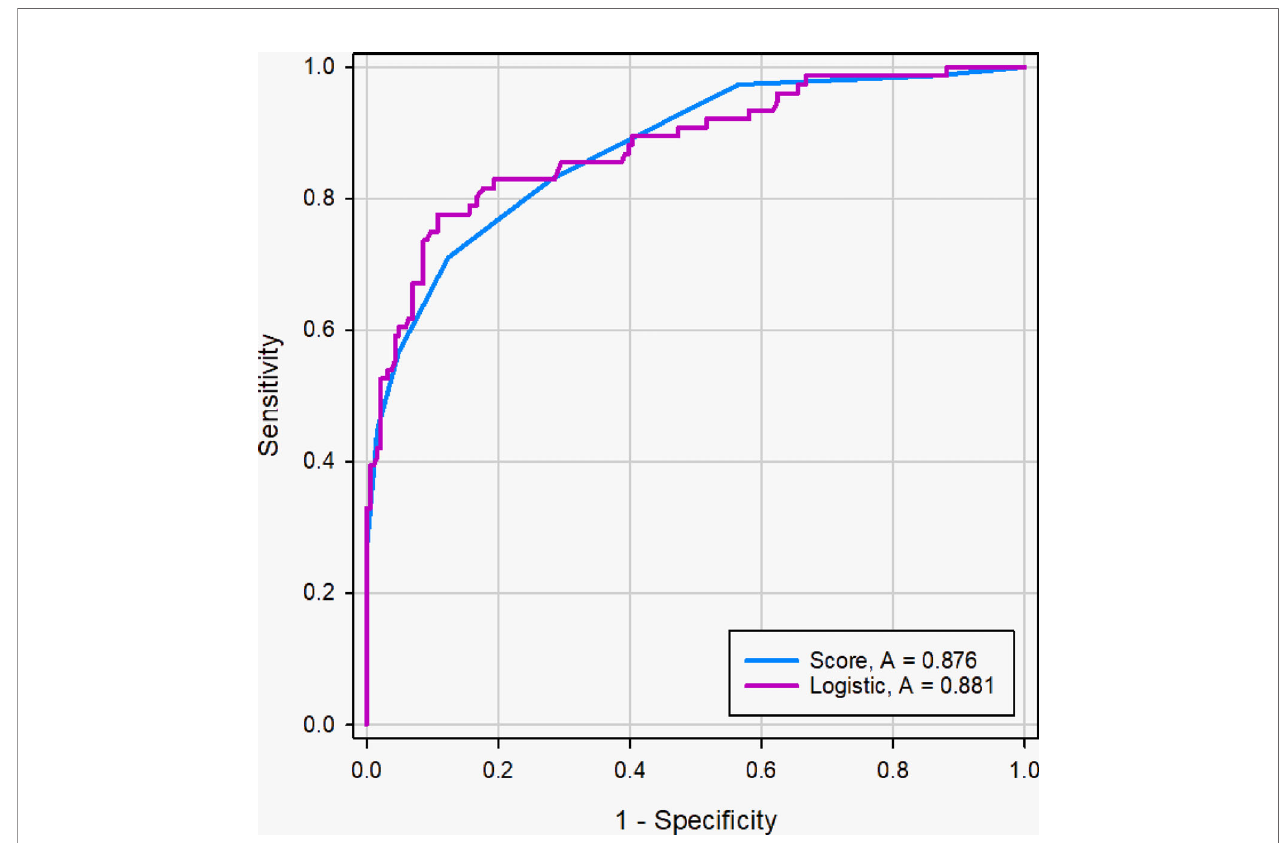
FIGURE 7 | ROC curve of logistic regression models and scoring system in the primary cohort. The difference of AUC was not signi fi cant between two models (0. 881 vs. 0. 876), and the DeLong et al. indicated that there was not signi fi cant difference in diagnostic performance between two models ( p